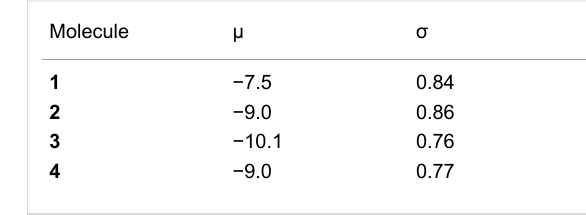
Table 1: Fitting parameters extracted from the fit of the conductance peaks to a log-normal